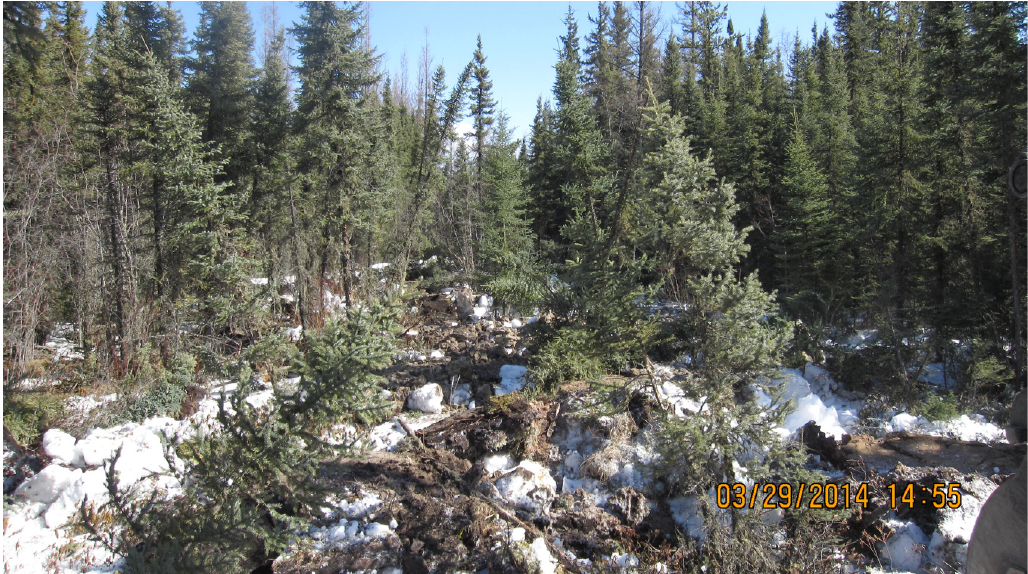
Figure 5. Lease road prior to treatment with mounding, tree-felling, tree-bending, and tree transplanting. Photo courtesy of MEG